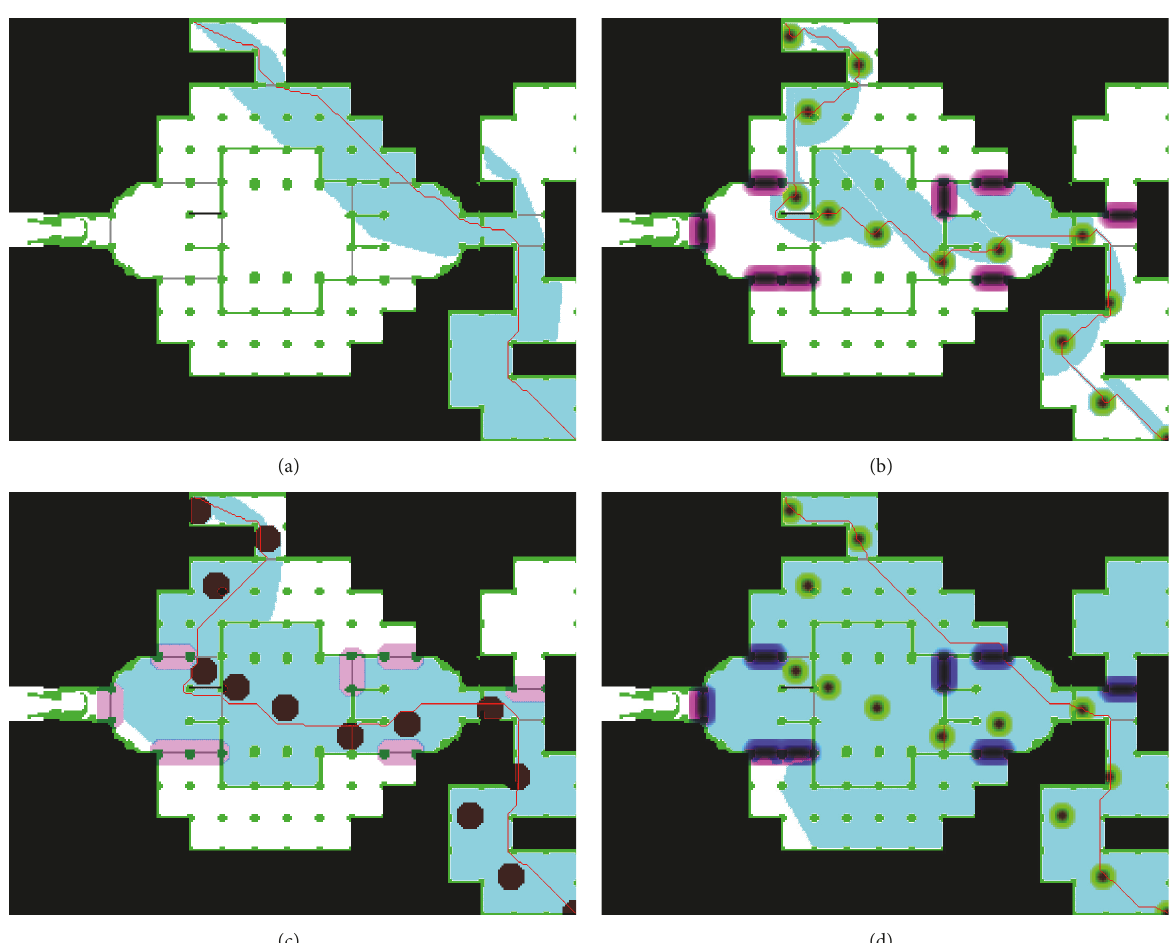
Figure 10: Distinct paths found within the arena2 map of Dragon Age: Origins by (a) A ∗ , (b) A ∗ T, (c) A ∗ RAP, and (d) A ∗ CAN pathfinders. Cyan nodes are neutral nodes visited during the space search. A ∗ T repulsor nodes in (b) maintain their original dark lilac-to-light-lilac colors because they were not visited. Therefore, and like DjT, A ∗ T repulsors sustain the space search. On the contrary, A ∗ CAN repulsors in (d) do not contain the space search because their original dark lilac-to-light-lilac colors were combined with cyan, resulting in purple-blue colored nodes. This color change means that A ∗ CAN repulsor nodes were visited. Also, the attractor nodes in (b) and (d) are in dark red-to-green because they were visited: that is, their original red-to-yellow color was blended with cyan. In turn, the A ∗ RAP repulsors (in light lilac) in (c) also sustain the expansion of the space search, though repulsor nodes own the same color because their influence values are constant in